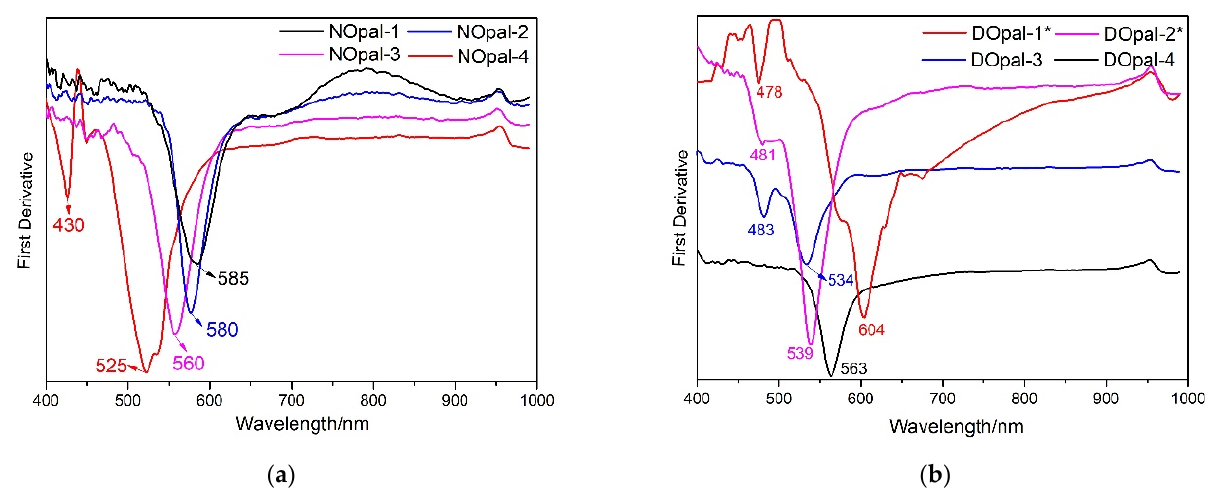
Figure 10. First derivative of the UV-VIS absorption spectra: ( a ) natural opals; ( b ) dyed opals. (The spectra DOpal-1* and DOpal-2* are the first-order derivative spectra derived from the processed data of DOpal-1 and DOpal-2).